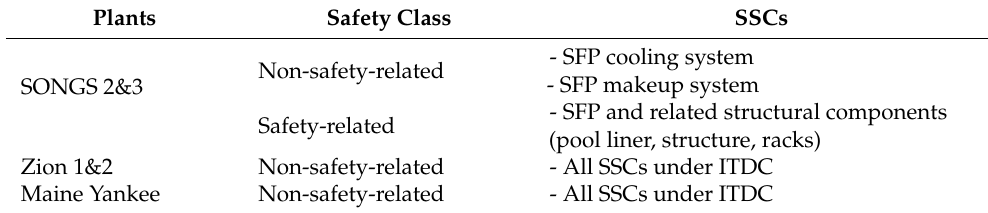
Table 10. Re-classification of safety classes in the